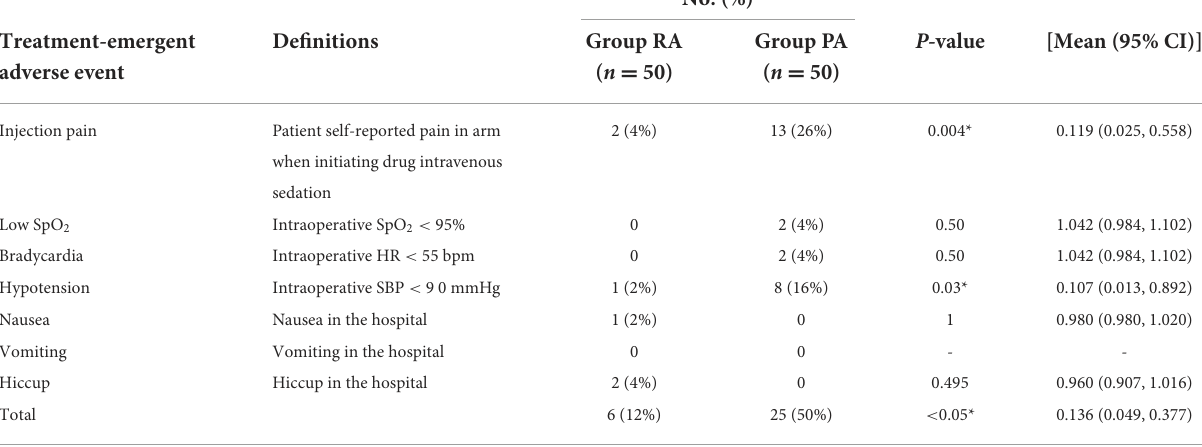
TABLE 3 The definition and incidence of adverse